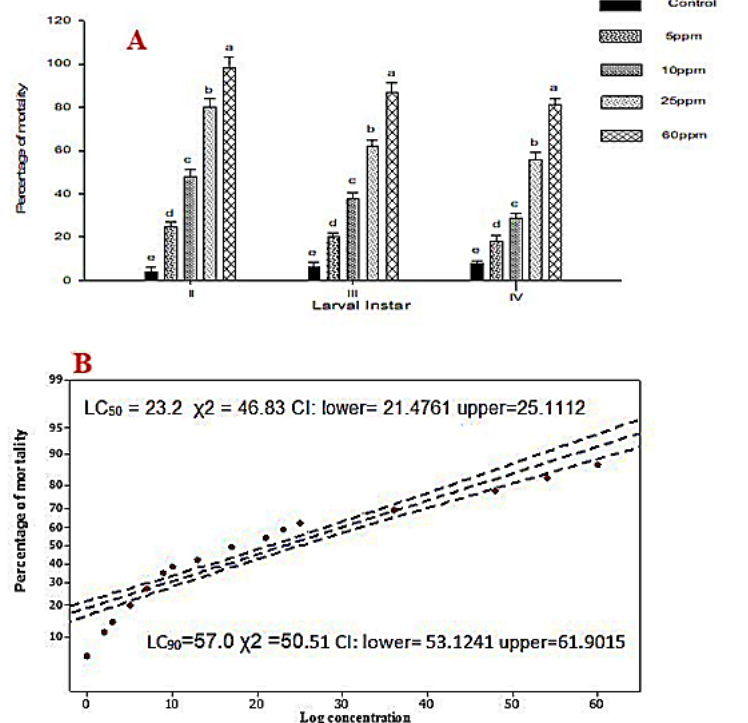
Figure 1. ( A ) Percent larval mortality was found to be pronounced in second, third and fourth instars of S. litura . Means ( ± (SE) standard error) followed by the same letters above bars indicate no significant difference ( p < 0.05) according to Tukey’s test. ( B ). Median lethal concentrations (LC 50 and LC 90 ) of Db-Precocene I against fourth instar of S. litura Probit